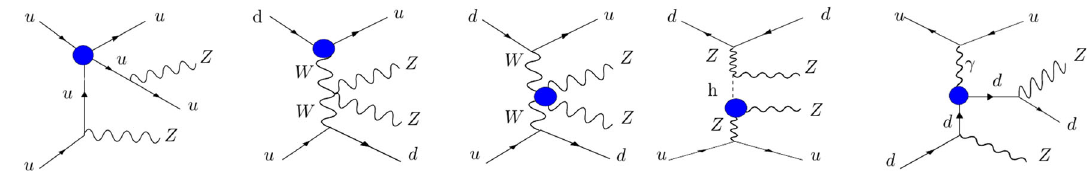
Fig. 5 Some of the Feynman diagrams contributing to the VBS(ZZ) process in dim = 6 EFT. The blobs represent the dimension-six